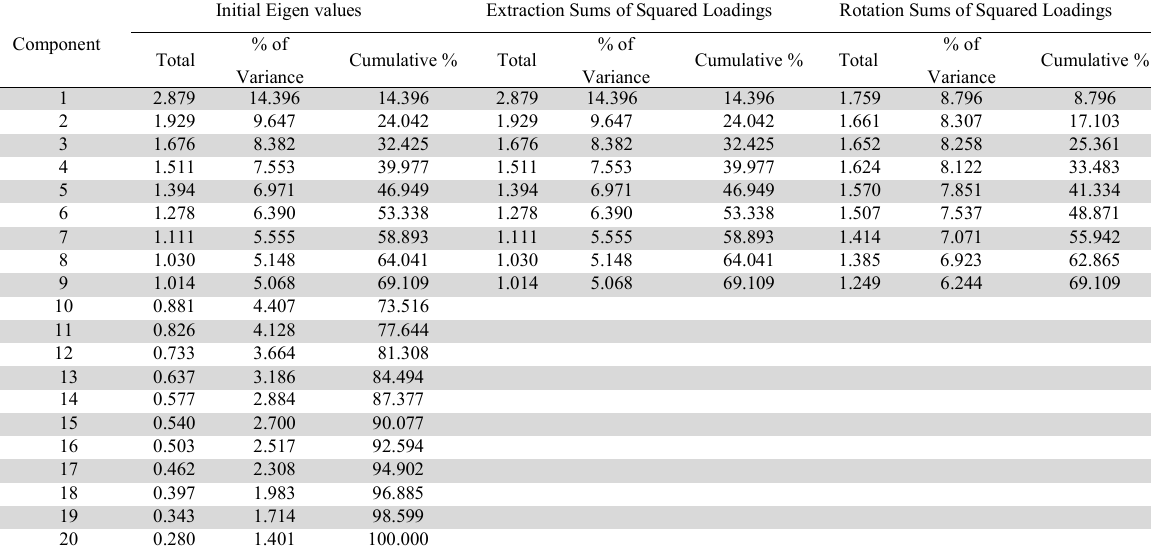
Total Variance Explained Component